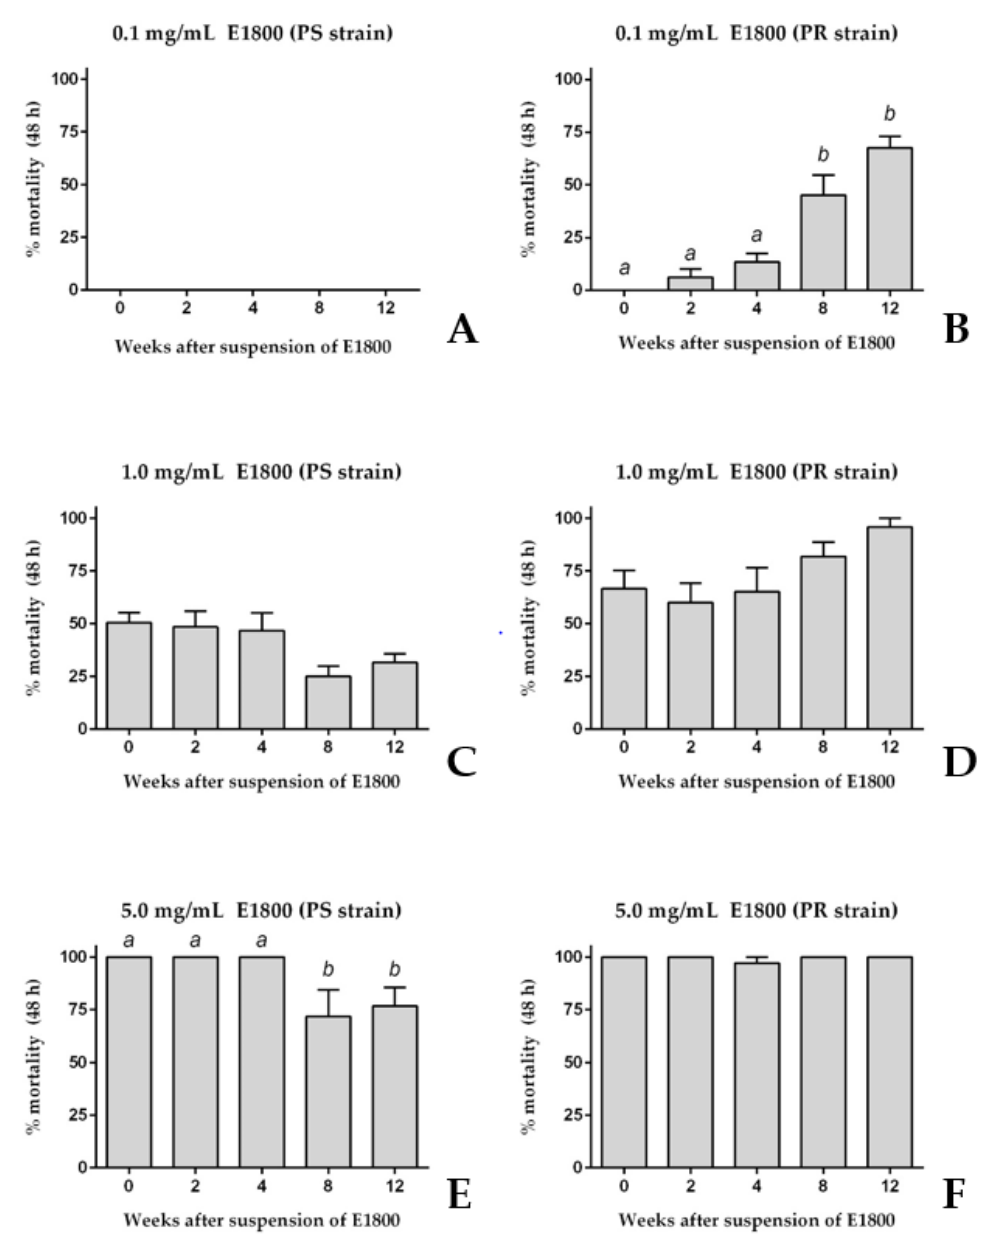
Figure 2. Acute toxicity (48 h) of E1800 suspensions against 1st instar Ae. aegypti of pyrethroid-susceptible (PS, panels ( A , C , E )) and pyrethroid-resistant (PR, panels ( B , D , F )) strains at several time points after being freshly suspended (week 0). Three different concentrations were tested: 0.1 mg/mL ( A , B ); 1.0 mg/mL ( C , D ); and 5.0 mL/mL ( E , F ). Values are means + standard errors of the mean based on six replicates of five larvae per concentration. Lower-case letters indicate statistical categorization of the means as determined using a one-way ANOVA and Tukey ´ s multiple comparison test ( p < 0.001).